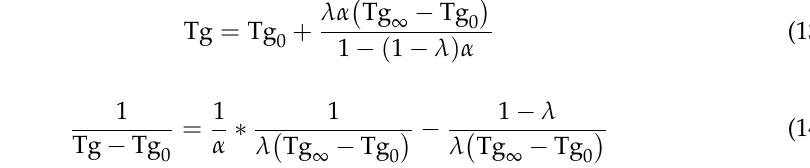
Figure 7. DSC curves obtained after 25 min incubation at different temperatures. Figure 6. DSC curves obtained after 25 min incubation at different